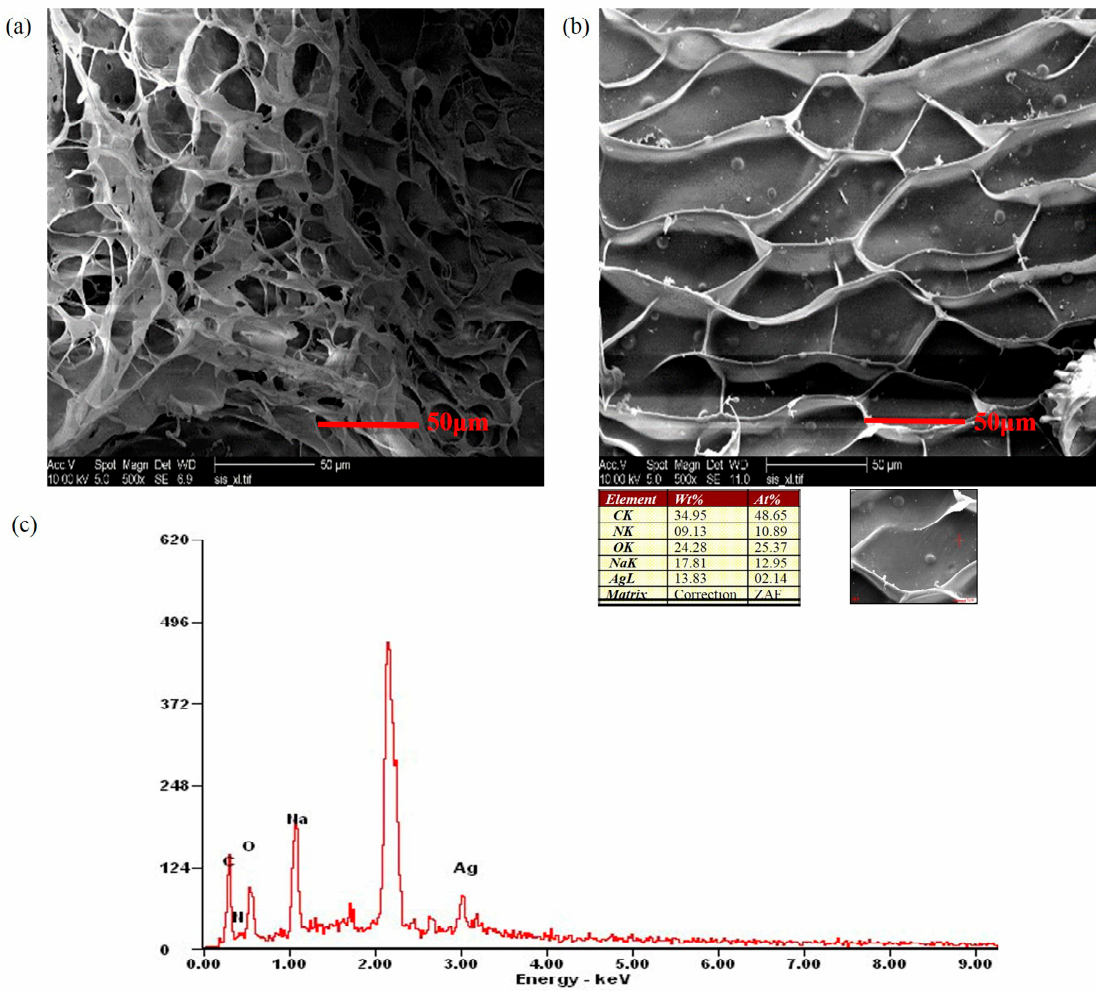
Figure 6. Scanning electron microscopy (SEM) of ( a ) CMC-g-PAA, ( b ) CMC-g-PAA/Ag, and ( c ) energy dispersive spectrometry (EDS) of CMC-g-PAA/Ag.